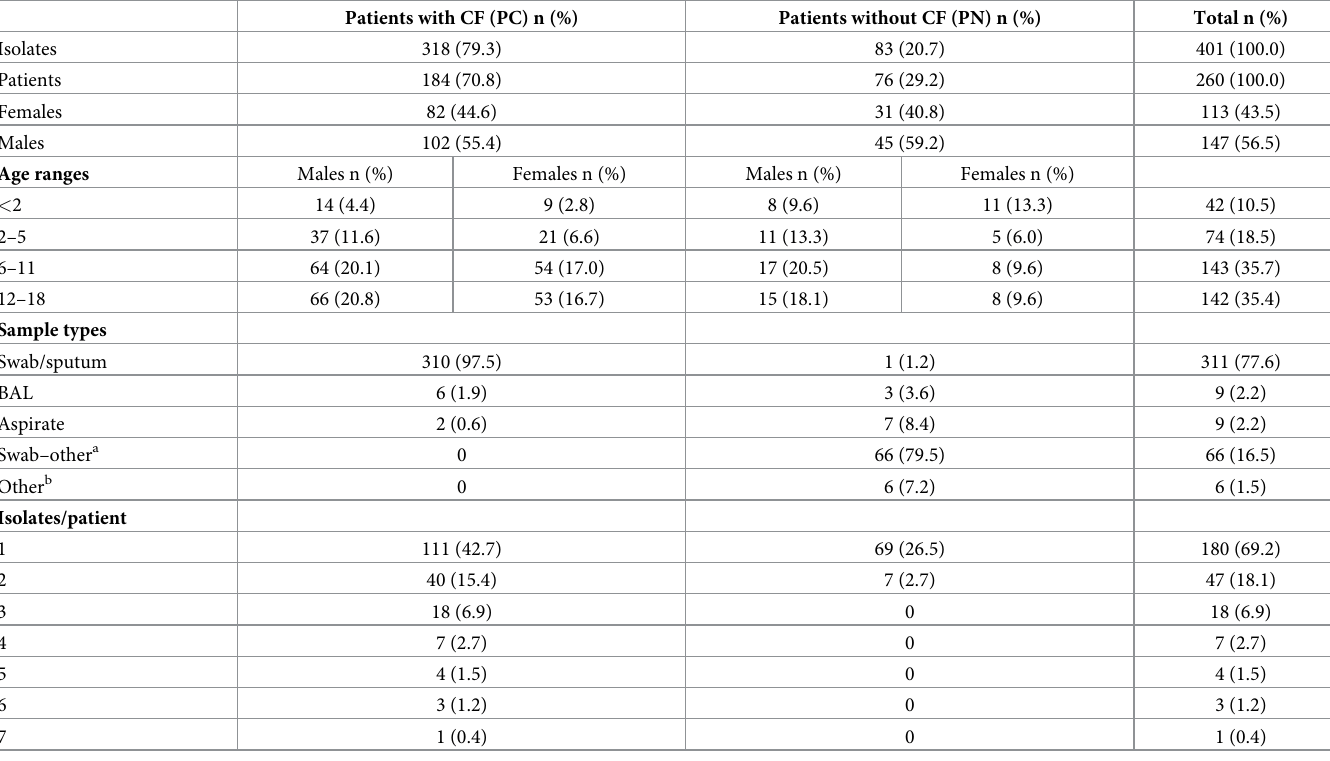
Table 1. Summary of isolates. Patients with CF (PC) n (%) Patients without CF (PN) n